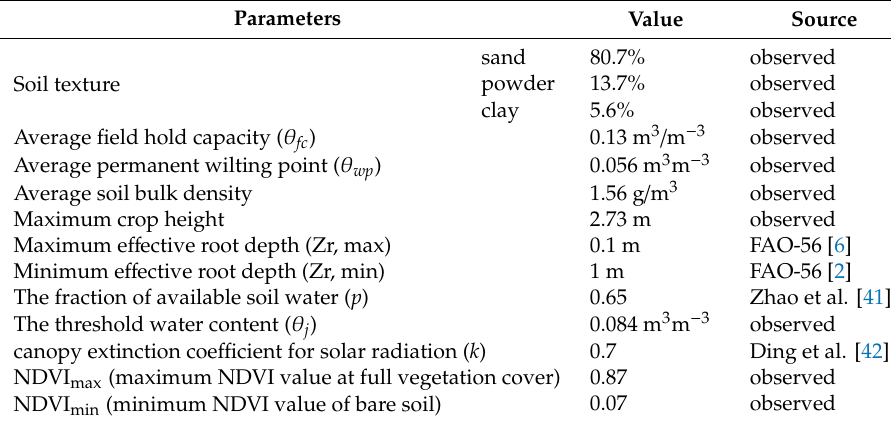
Table 2. Soil characteristics and parameters used in the modified FAO-56 dual crop coe ffi cient assimilation procedure for